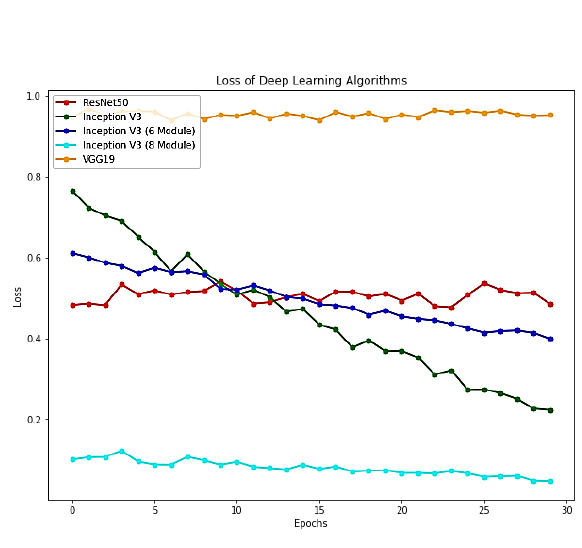
Figure 7. Loss of Models on Train set